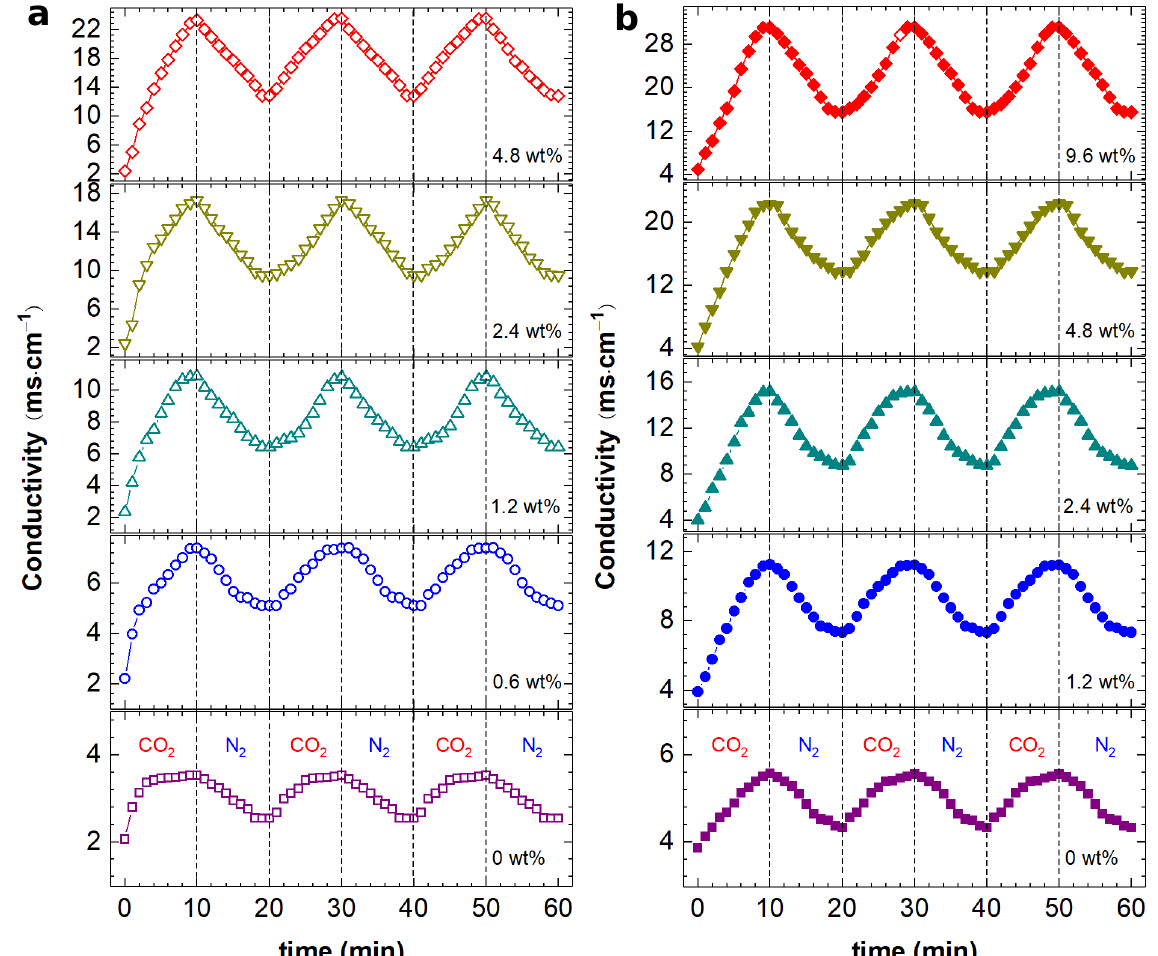
Figure 8. Variation in conductivity of ( a ) 0.65 wt% and ( b ) 1.30 wt% NaPAA solutions at different DMEA concentrations, while alternatively bubbling CO 2 and N 2 at 25 °C.